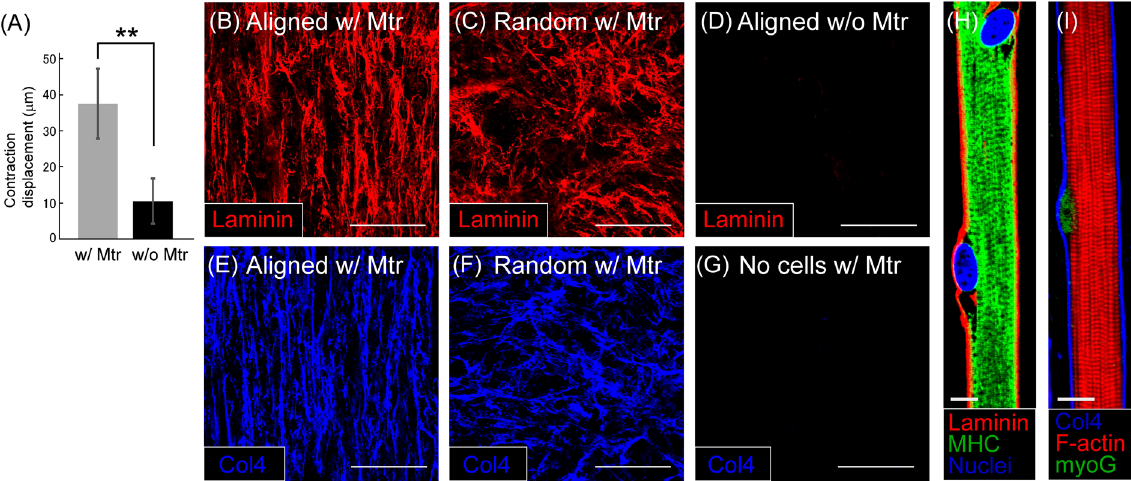
Figure 3. ( A ) Comparison of contraction displacement between myofiber sheets cultured in the fibrin-based gels with (w/ Mtr) and without Matrigel (w/o Mtr). (n = 5) ( ** P < 0.01) ( B,C ) Laminin structure shown in the gel containing Matrigel (w/ Mtr). Myofibers are aligned (B) or randomly oriented in the gel (C) . ( D ) No laminin formation observed in the gel without Matrigel (w/o Mtr). The aligned cells produced no laminin structure in the gel. ( E,F ) Formation of anisotropic and isotropic structures of type IV collagen in the Matrigel- containing gels with (E) aligned and (F) randomly oriented myofibers. ( G ) No formation of type IV collagen in the gel containing Matrigel, but without cells. ( H ) Laminin surrounding a myofiber in the myofiber sheet. (red: laminin, green: myosin heavy chain (MHC), blue: nuclei) ( I ) Type IV collagen surrounding a myofiber (blue: Type IV collagen, red: F-actin, green: myogenin (myoG)) Scale bars: 100 μ m ( B–G ), 10 μ m ( H,I